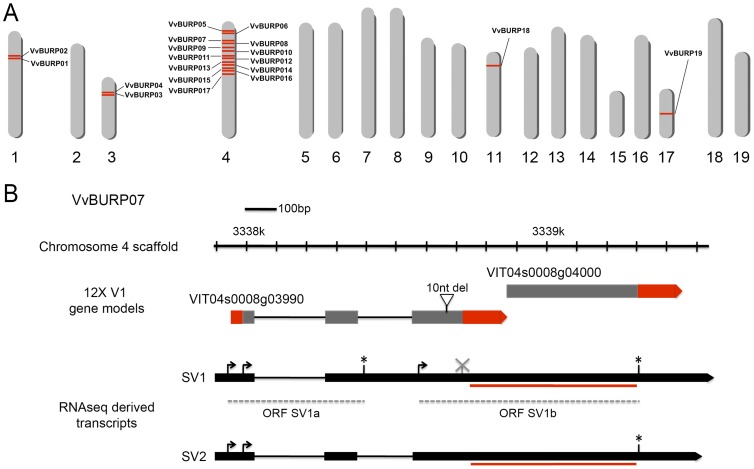
BURP domain-containing gene models in the grapevine genome.A) Gene positions in chromosomes 1, 3, 4, 11 and 17. An expanded cluster of closely related BURP genes (from the RD22 family) was found in chromosome 4. B) Assistance in gene model verification and re-annotation through the use of RNA-Seq data. The case for VvBURP07 is shown as an example, where two incomplete BURP models from the 12X V1 prediction are no longer supported as independent units. The RNA-Seq data shows that a 10-nucleotide deletion was present in the 12X genome version, possibly corresponding to an error in the sequencing, as this deletion was not present in the 8X genome version. The two models actually represent one single annotation containing a complete BURP domain. SV: splicing variant. Red line under each SV represents the region coding for the BURP domain. Asterisks: stop codons in a corresponding ORF. Grey X: abolished stop codon in the SV ORF compared to the 12X annotation. For further inspection of this and other gene model re-annotations, see Table S1 and Figure S1.